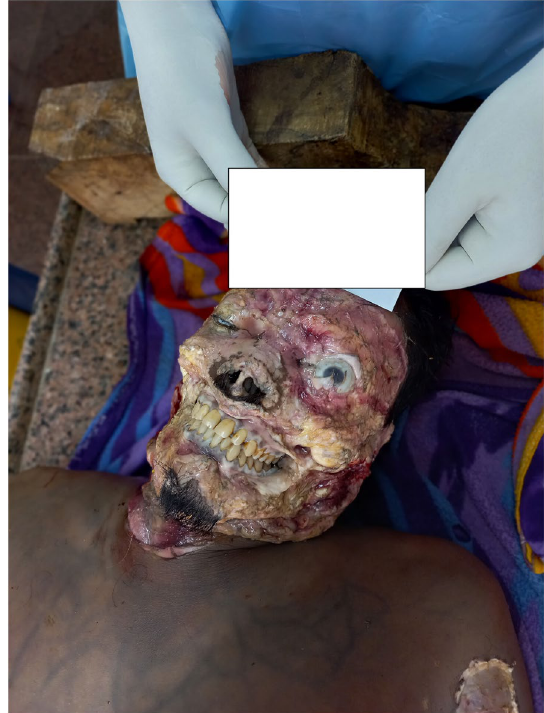
Fig. 3 Aquatic predator activity (freshwater crab)—circular defect on the front of the left side of the